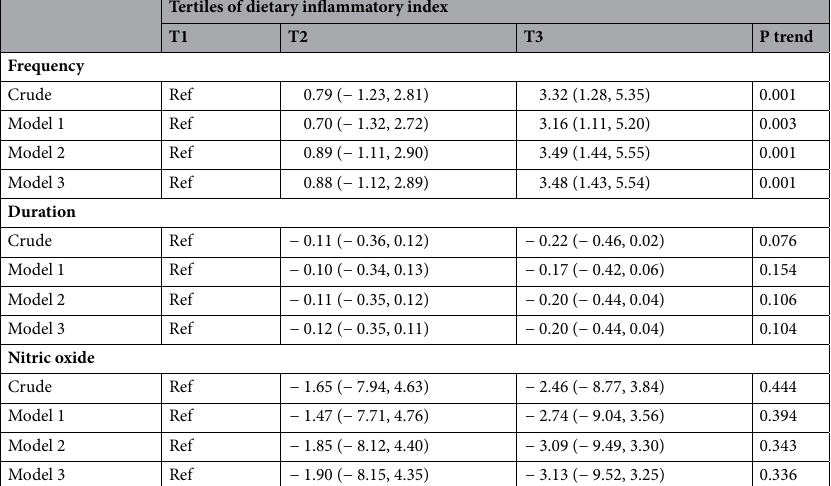
Table 3. Beta (β) and 95% confidence interval for serum nitric oxide, headache frequency, and duration across tertiles of the dietary inflammatory index. Data are presented as β (95% confidence interval) and obtained from linear regression. Crude: Unadjusted. Model 1: Adjusted for age and sex. Model 2: Model 1 + marital status, smoking status, migraine characteristic, family history, mean arterial pressure, and physical activity. Model 3: Model 2 + body mass index. HIT Headache Impact Test. P < 0.05 was considered statistically